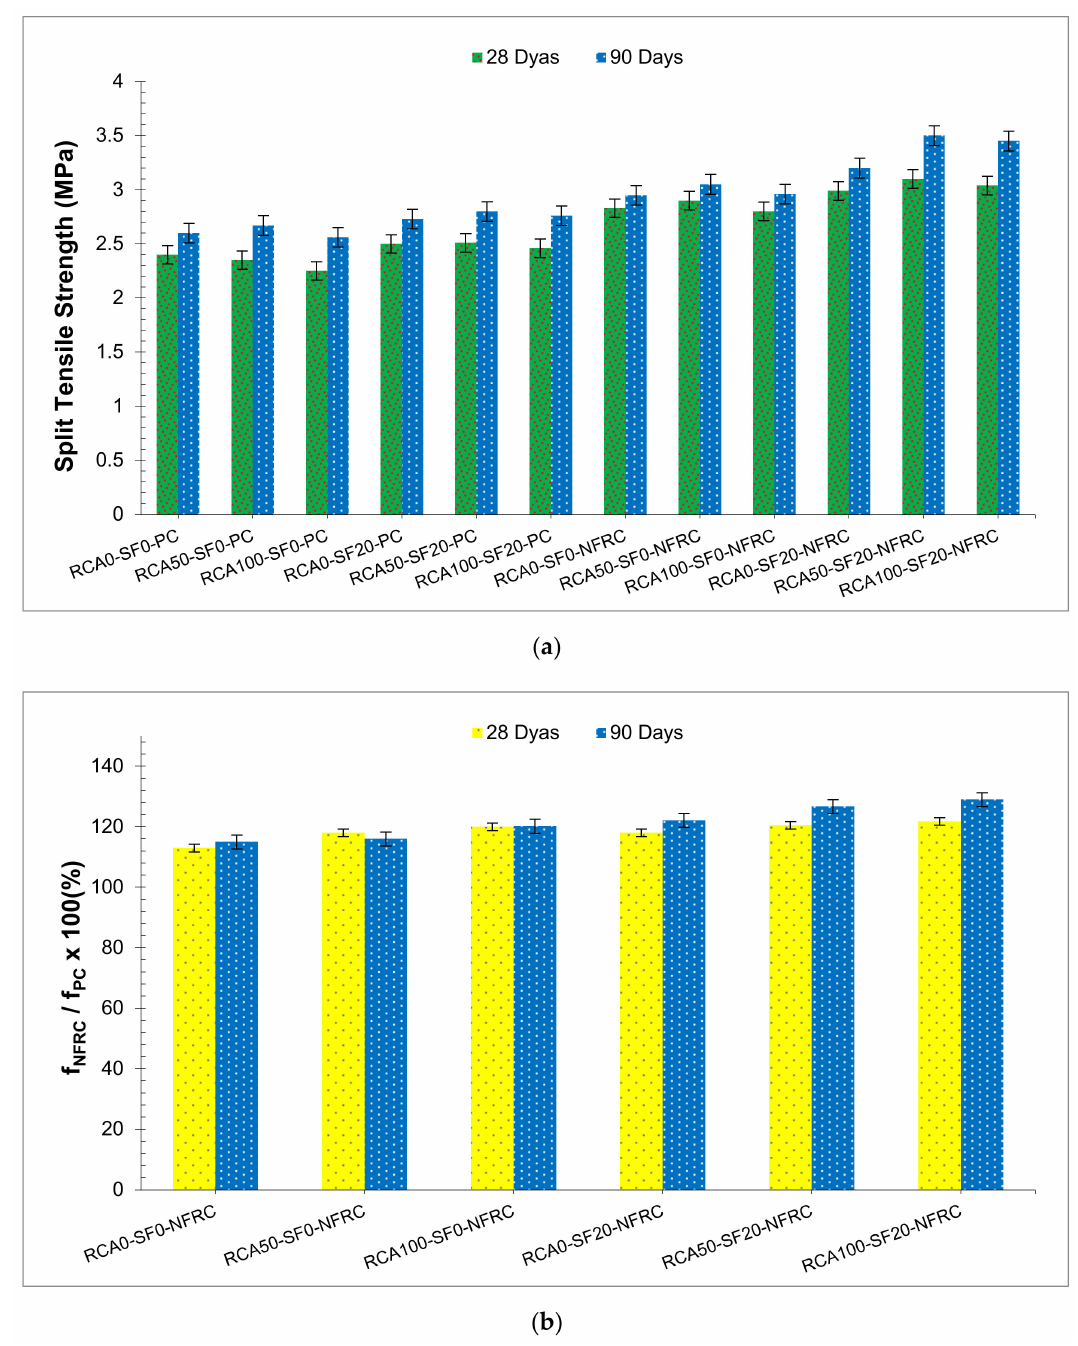
Figure 3. ( a ) Split Tensile Strength ( b ) Split Tensile Strength of Each NFRC Mix W.R.T Plain Con- crete